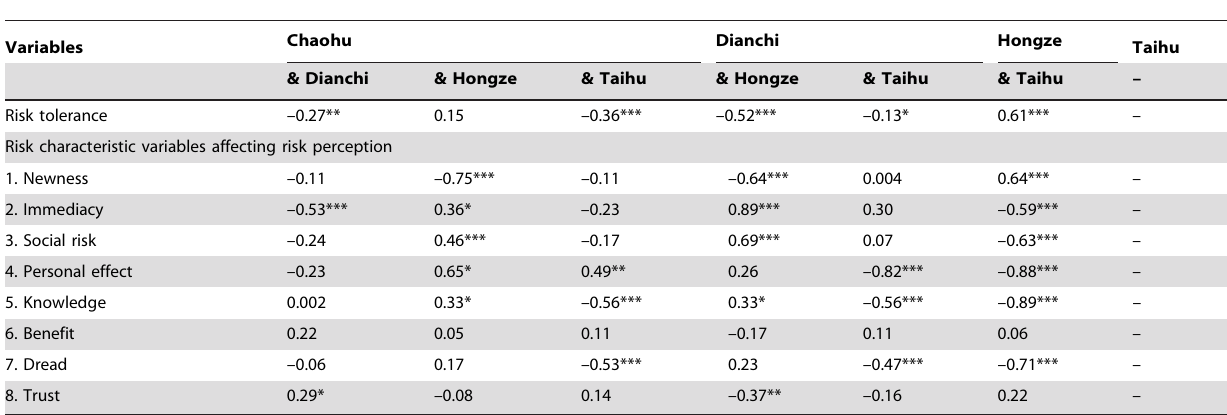
Note: See Table 3 for variable description. * p , 0.05; ** p , 0.01;